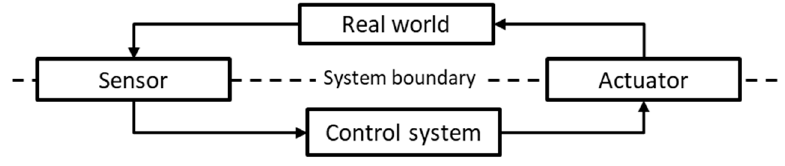
Figure 3. Model of a real-time system.